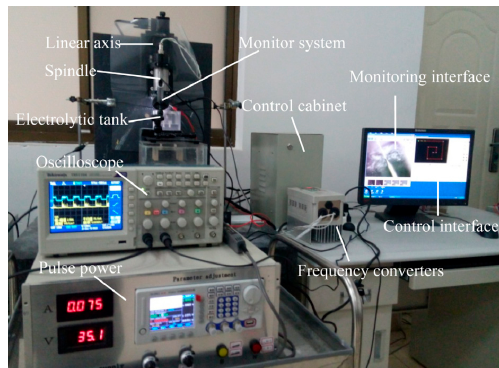
Figure 2. Experimental system of ECDM.